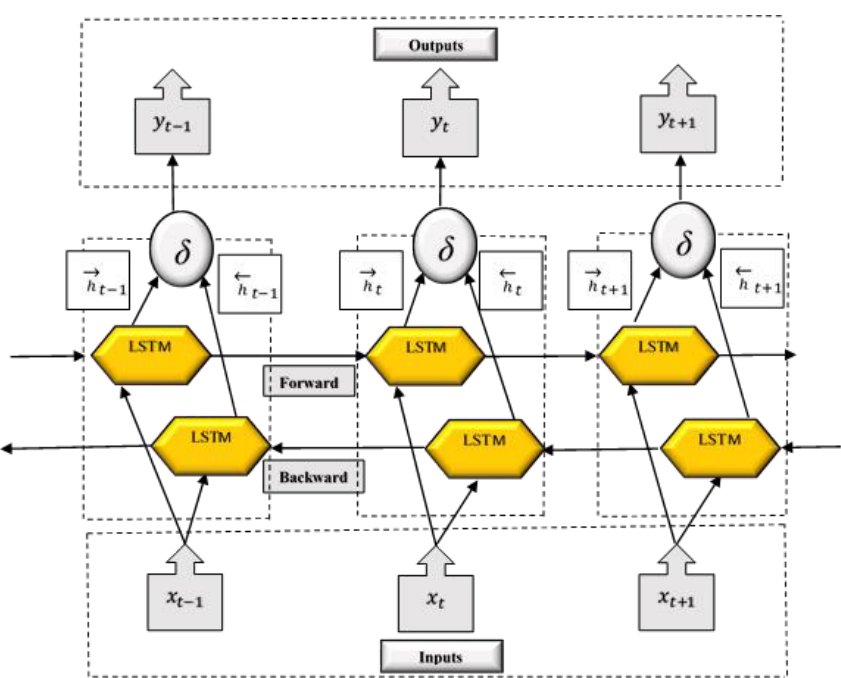
Figure 10. The BiLSTM cell structure at time step 𝒕 . The architecture has the forward and backward flow arrangement of connected LSTM layers.